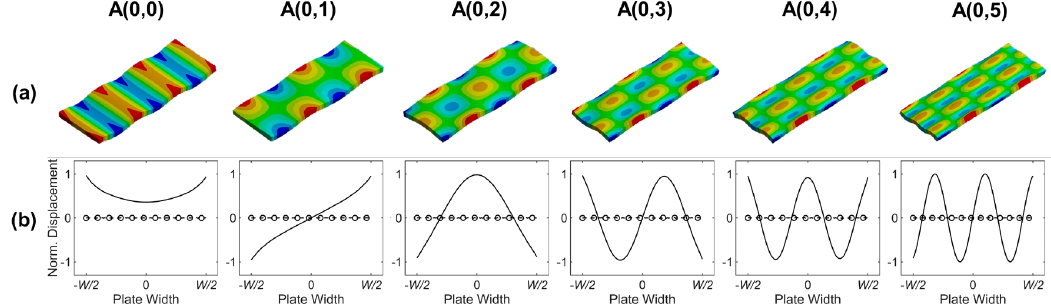
Figure 3. Wave structures of A(0, n ) modes in SS304 plate with 1.2 mm thickness and 15 mm width at 1.0 MHz: ( a ) wave structures of A(0, n ) modes and ( b ) displacement distributions in the width direction on the neutral plane( z =0); solid line: out-of-plane direction ( z direction), dashed line: in-plane horizontal direction ( y direction), and circle markers: in-plane extensional direction ( x direction).